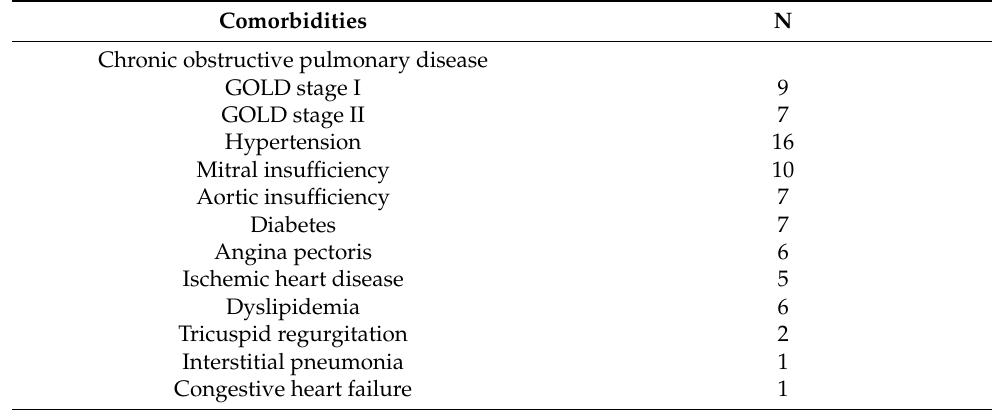
Table 1. Comorbidities of Patient. Comorbidities N Chronic obstructive pulmonary disease GOLD stage I 9 GOLD stage II 7 Hypertension 16 Mitral insufficiency 10 Aortic insufficiency 7 Diabetes 7 Angina pectoris 6 Ischemic heart disease 5 Dyslipidemia 6 Tricuspid regurgitation 2 Interstitial pneumonia 1 Congestive heart failure 1 GOLD, Global Initiative for Chronic Obstructive Lung